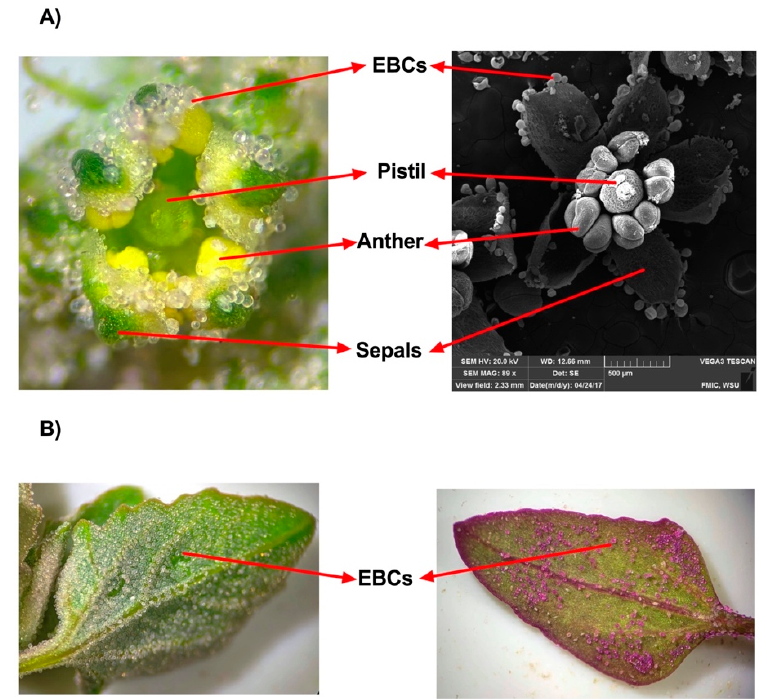
Figure 2. Epidermal bladder cells (EBCs). ( A ) EBCs localized in the quinoa flower. Left, micrograph of quinoa flower. Right, scanning electron micrograph of quinoa flower. ( B ) Micrograph of quinoa leaves in two different varieties of EBCs.